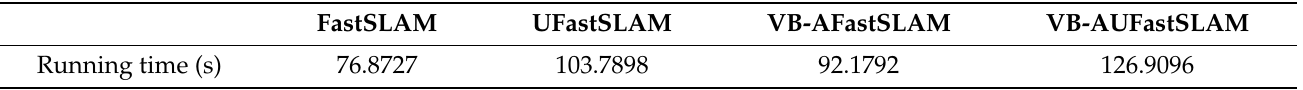
Table 7. Running time